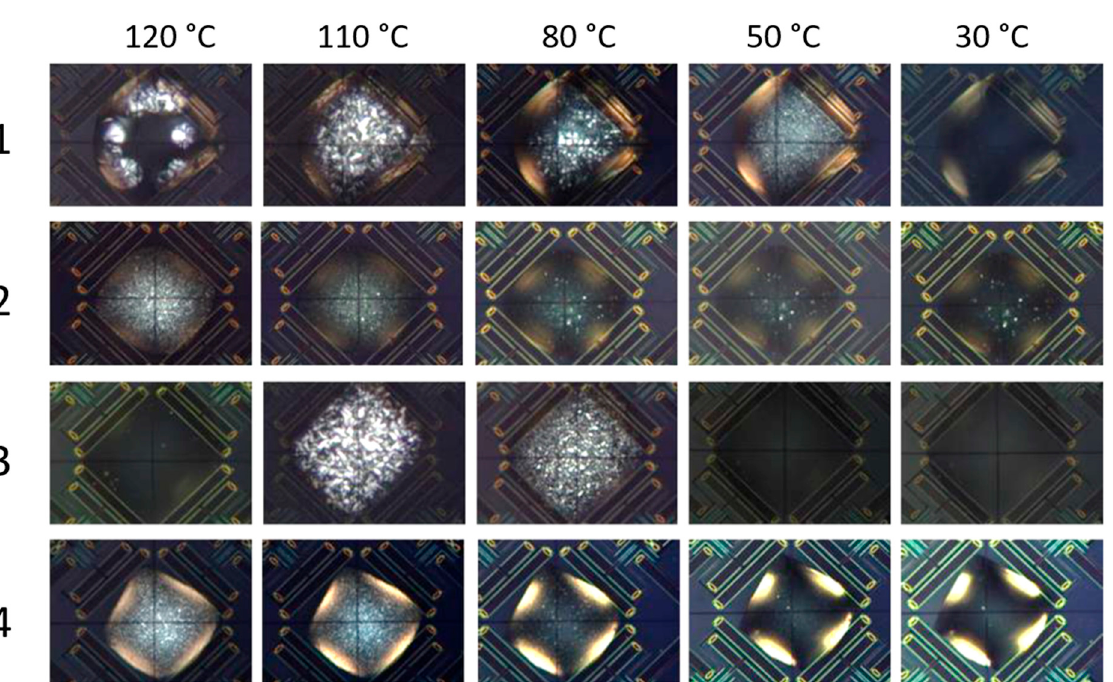
Figure 7. Isothermal crystallization peak-time depending on the crystallization temperature deter- mined from the isothermal crystallization curves.